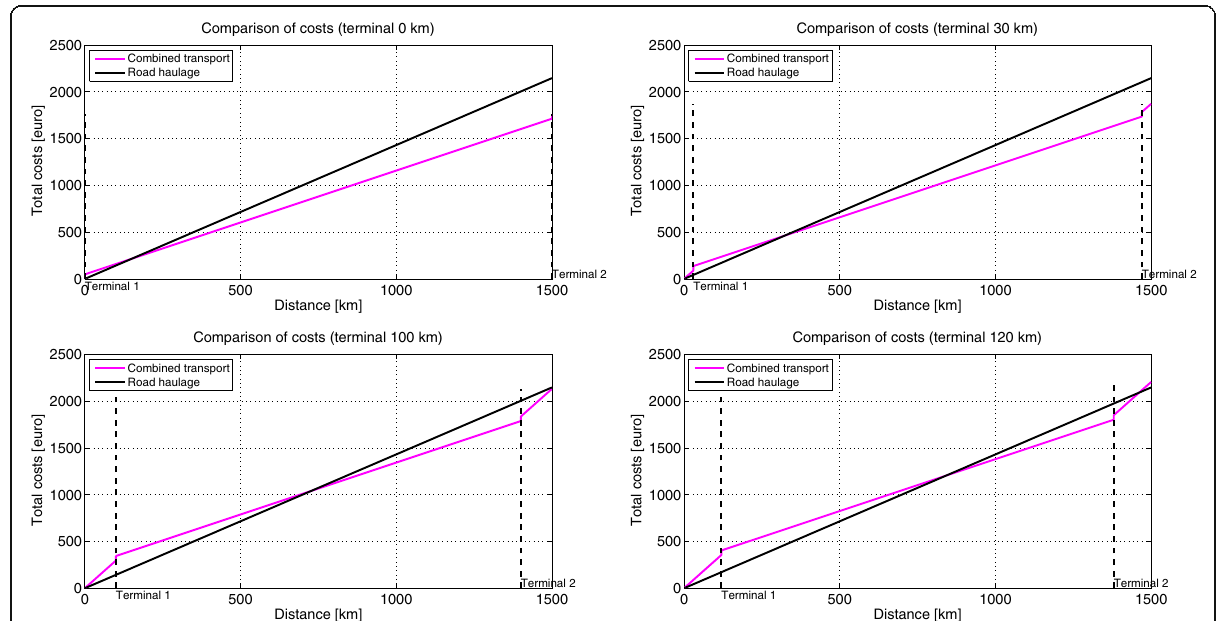
Fig. 7 Comparison of the total costs for freight transport as a function of the terminal location (related to the transport of one standard ITU 40 ′